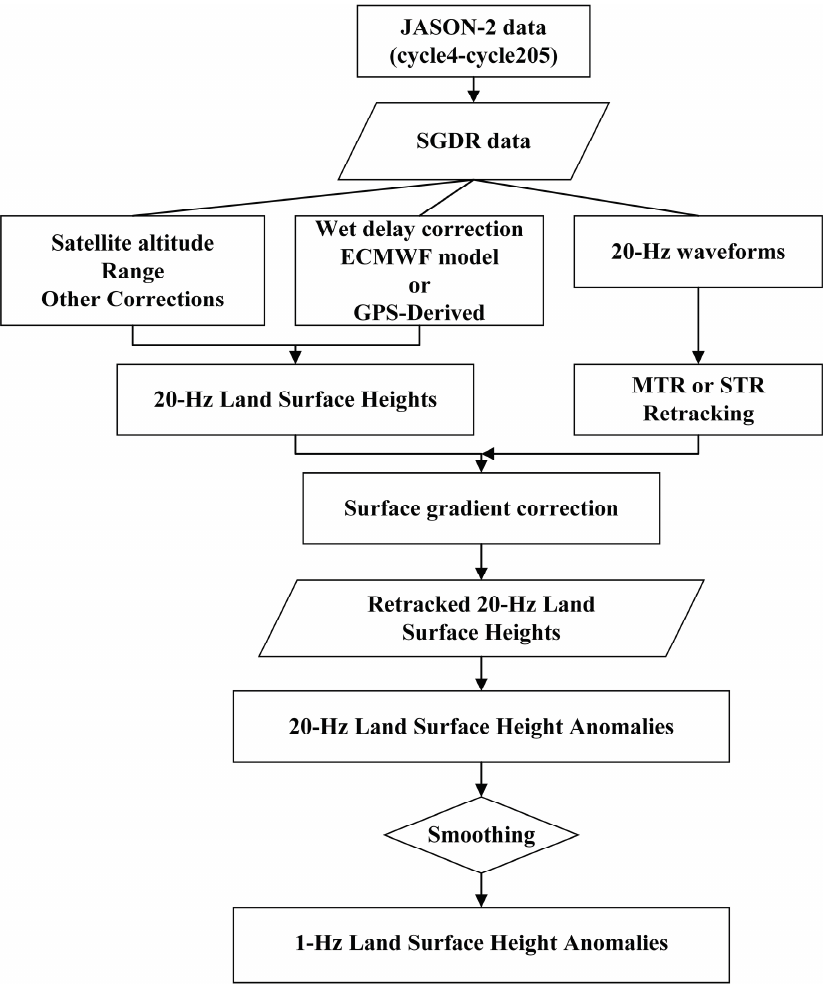
Figure 4. Flowchart of retrieving J-2 LSA by waveform